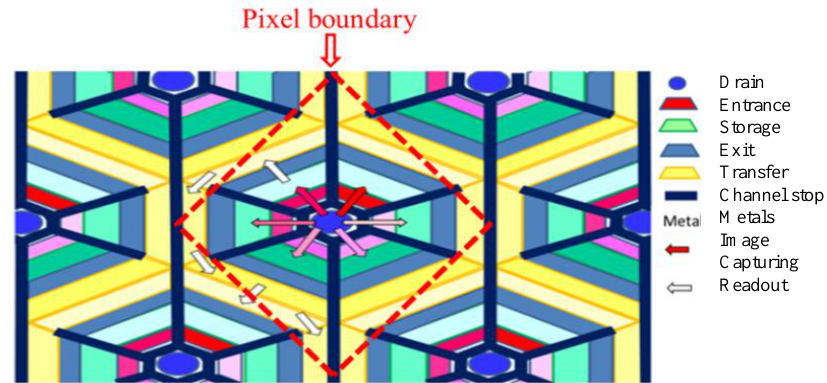
Figure 9. A distorted hexagonal CCD multi-collection-gate BSI image sensor.